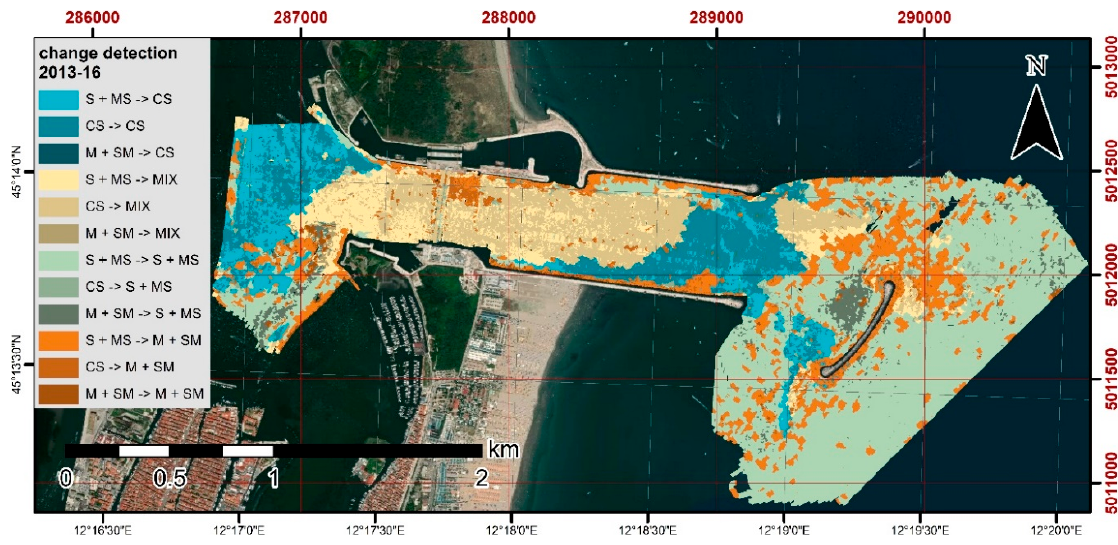
Figure 6. Result of change detection spatial analysis for the Chioggia 2013 and 2016 datasets. Colors refer to transitions between classes, described in the legend.